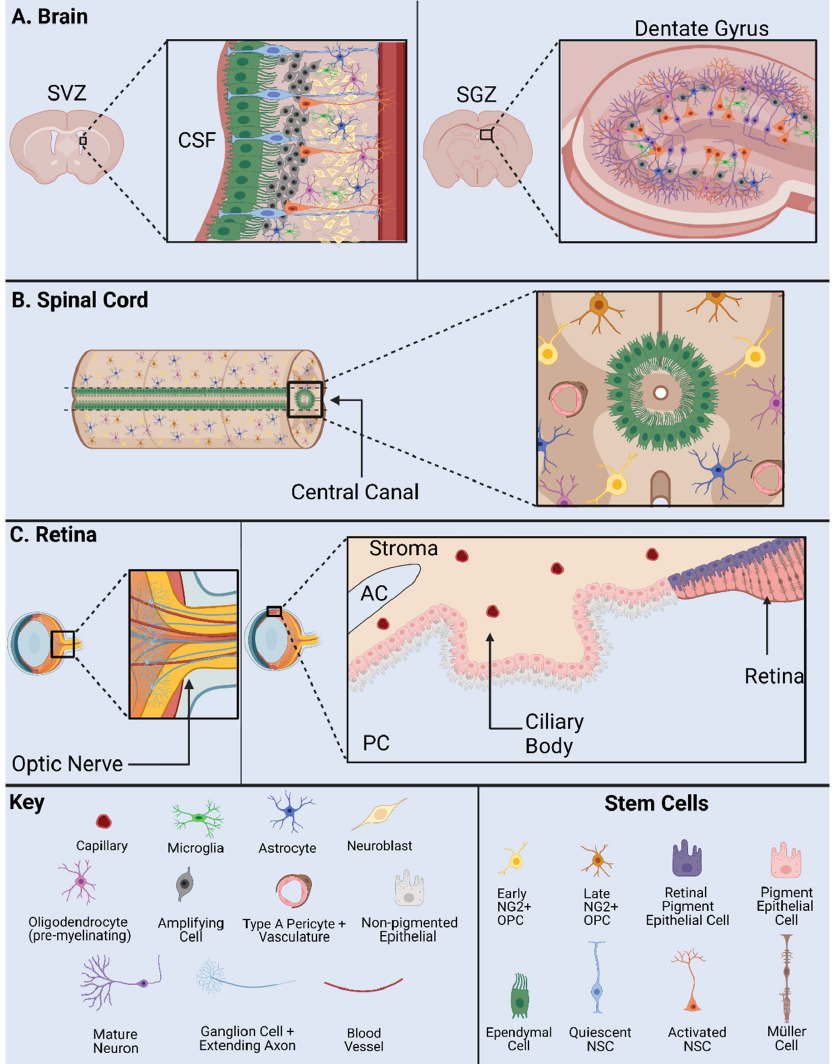
Figure 2. NSPC Niche in mammals: the SVZ and SGZ in the brain ( A ); the ependymal cells and NG2 cells in the spinal cord ( B ); and the base of the optic nerve, the Müller glia, and the pig- ment epithelium in the retina ( C ). AC, anterior chamber; CSF, cerebrospinal fluid; PC, posterior chamber; SVZ, subventricular zone; SGZ, subgranular zone. Adapted from Cutler and Koko- vay, 2020 [26] ( A ); Sabelström et al., 2014 [27], Andreotti et al., 2019; Picoli et al., 2019 [28,29] ( B ); Yoshida et al., 2000 [30] ( C